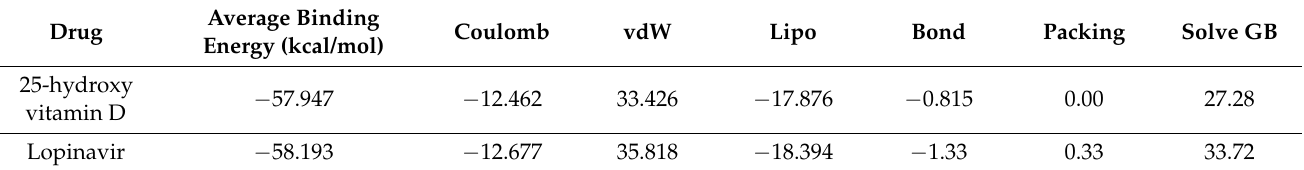
Table 2. The contributions of various energy components to the total binding energy of the 25-hydroxy vitamin D-Mpro complexes